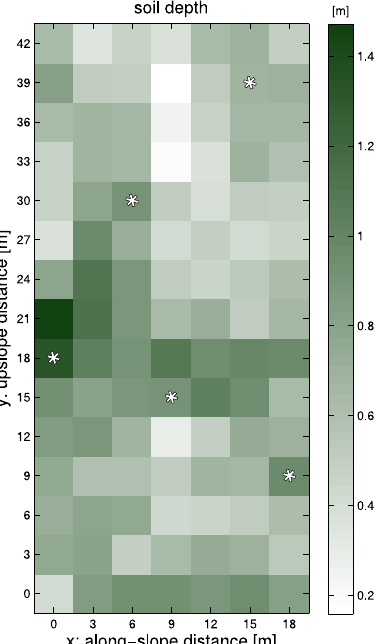
Fig. 2. Soil depth distribution. The locations of sink hotspots are indicated with asterisks – these are the locations where the reference model applies r sink ( high ) . At the complementary locations, the reference model applies r sink ( low ) .